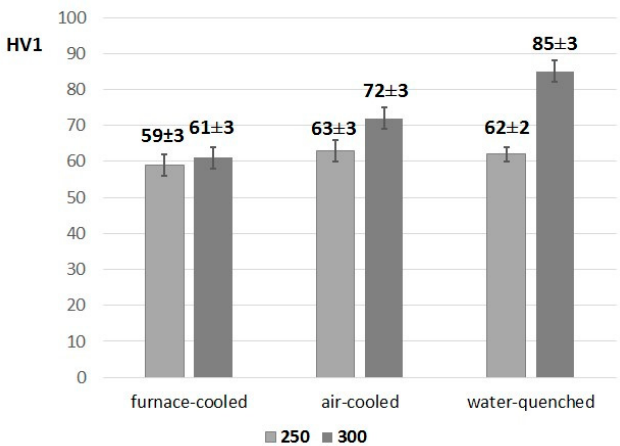
Figure 2. Hardness values obtained for heat-treated Zn-4Al alloy at 250 and 300 °C using various cooling rates.